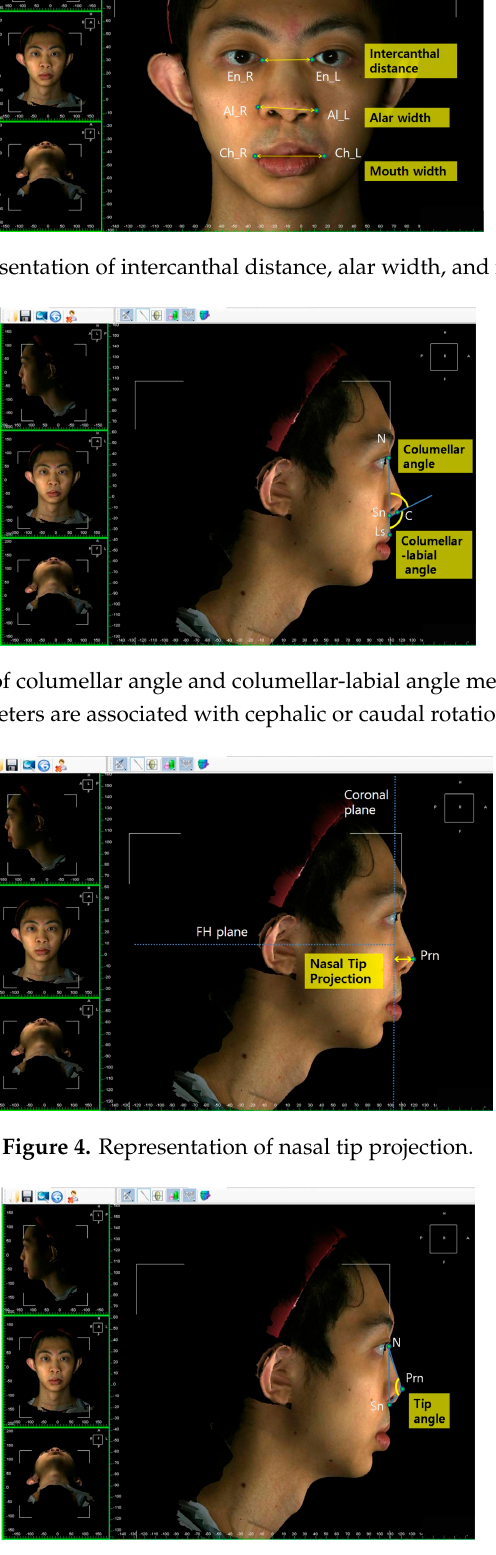
Figure 5. Representation of tip angle.